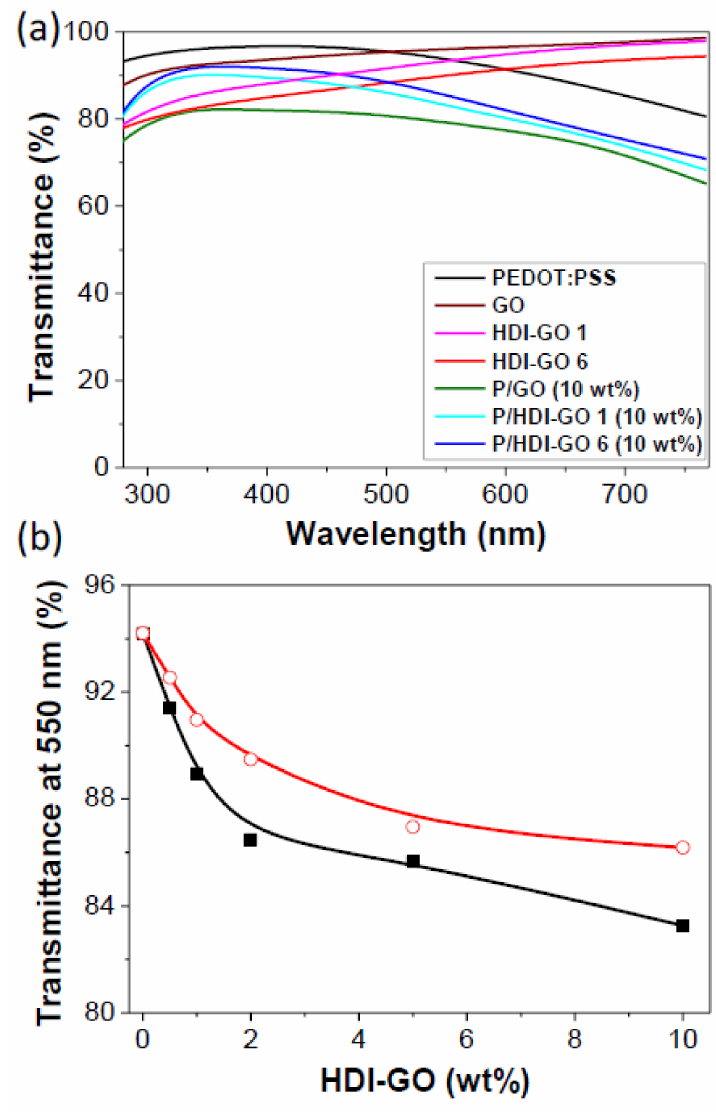
Figure 5. ( a ) Optical transmittance of neat PEDOT:PSS, GO, HDI-GO, and the nanocomposites with 10 wt % loading. ( b ) Optical transmittance at 550 nm of nanocomposites reinforced with HDI-GO 6 ( open circles ) and HDI-GO 1 ( solid squares ) as a function of the HDI-GO